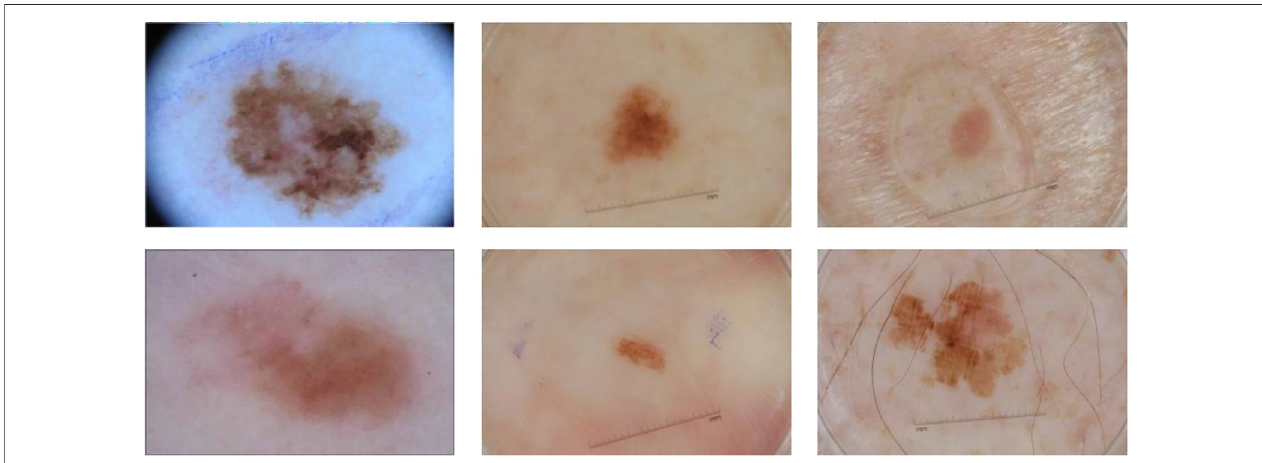
FIGURE 1 | Some samples of dermoscopy images. From left to right: malignant melanoma, benign nevis, and seborrheic keratosis.